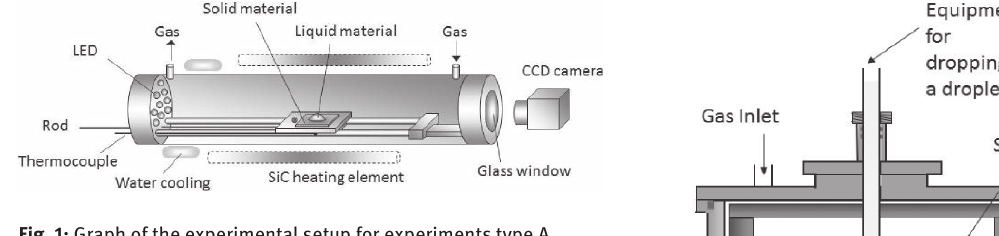
Fig. 1: Graph of the experimental setup for experiments type A